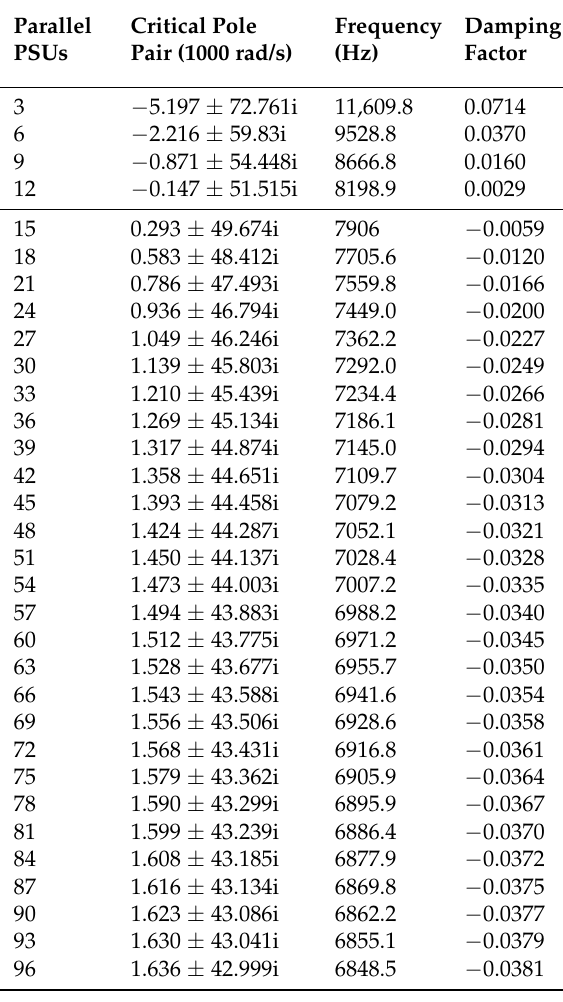
Table A1. Critical pole